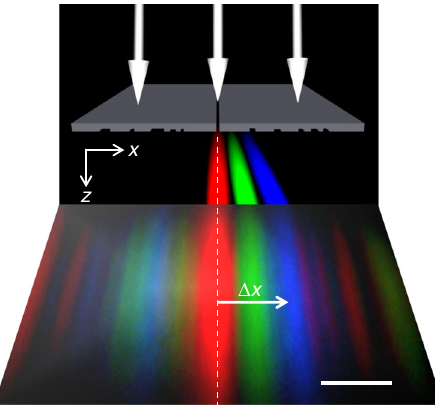
Fig. 3 Spectrum-splitting using the aperiodic slit-groove device. top panel, Schematic illustration of the device transmission under “ reverse illumination ” from the non-patterned side. Owing to reciprocity, the device when illuminated with TM polarized white light laser source from the non-patterned side is able to spatially separate the three colours along well-de fi ned discrete angles on the same side of the surface normal. bottom panel, Wide- fi eld projected image of the transmitted light, collected at a distance Δ z = 17.5 μ m from the exit surface of the device, using an inverted optical microscope (×100, NA = 0.75 microscope objective) connected to a colour-CCD camera. Scale bar along the x -axis in the CCD image represents 6.5 μ m. The diffraction angle θ ¼ tan (cid:2) 1 Δ x = Δ z ð Þ for the three colours is determined by directly measuring the distance of the local intensity maximum of the red, green, and blue streaks relative to the center of the slit, Δ x . The experimentally measured diffraction angles for the red, green, and blue colours (0° ± 0.49°, 9.72° ± 0.47°, and 18.92° ± 0.44°, respectively) match closely the angles speci fi ed for angle-selective colour- fi lter operation under “ forward illumination ” (0°, 10°, and 20°,